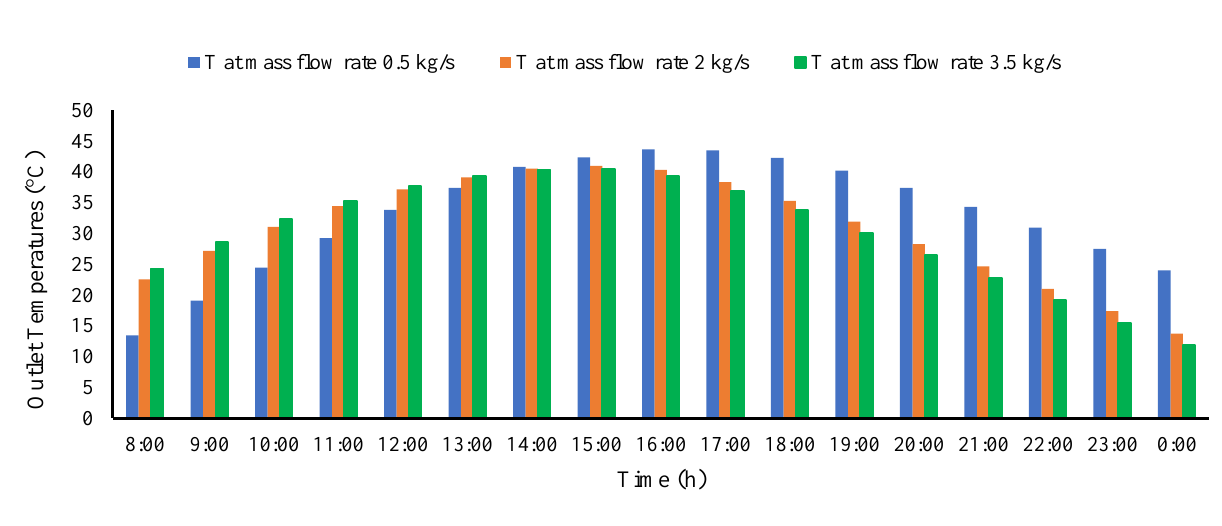
Figure 5 . Room temperature at the time in the days with different mass flow rates.